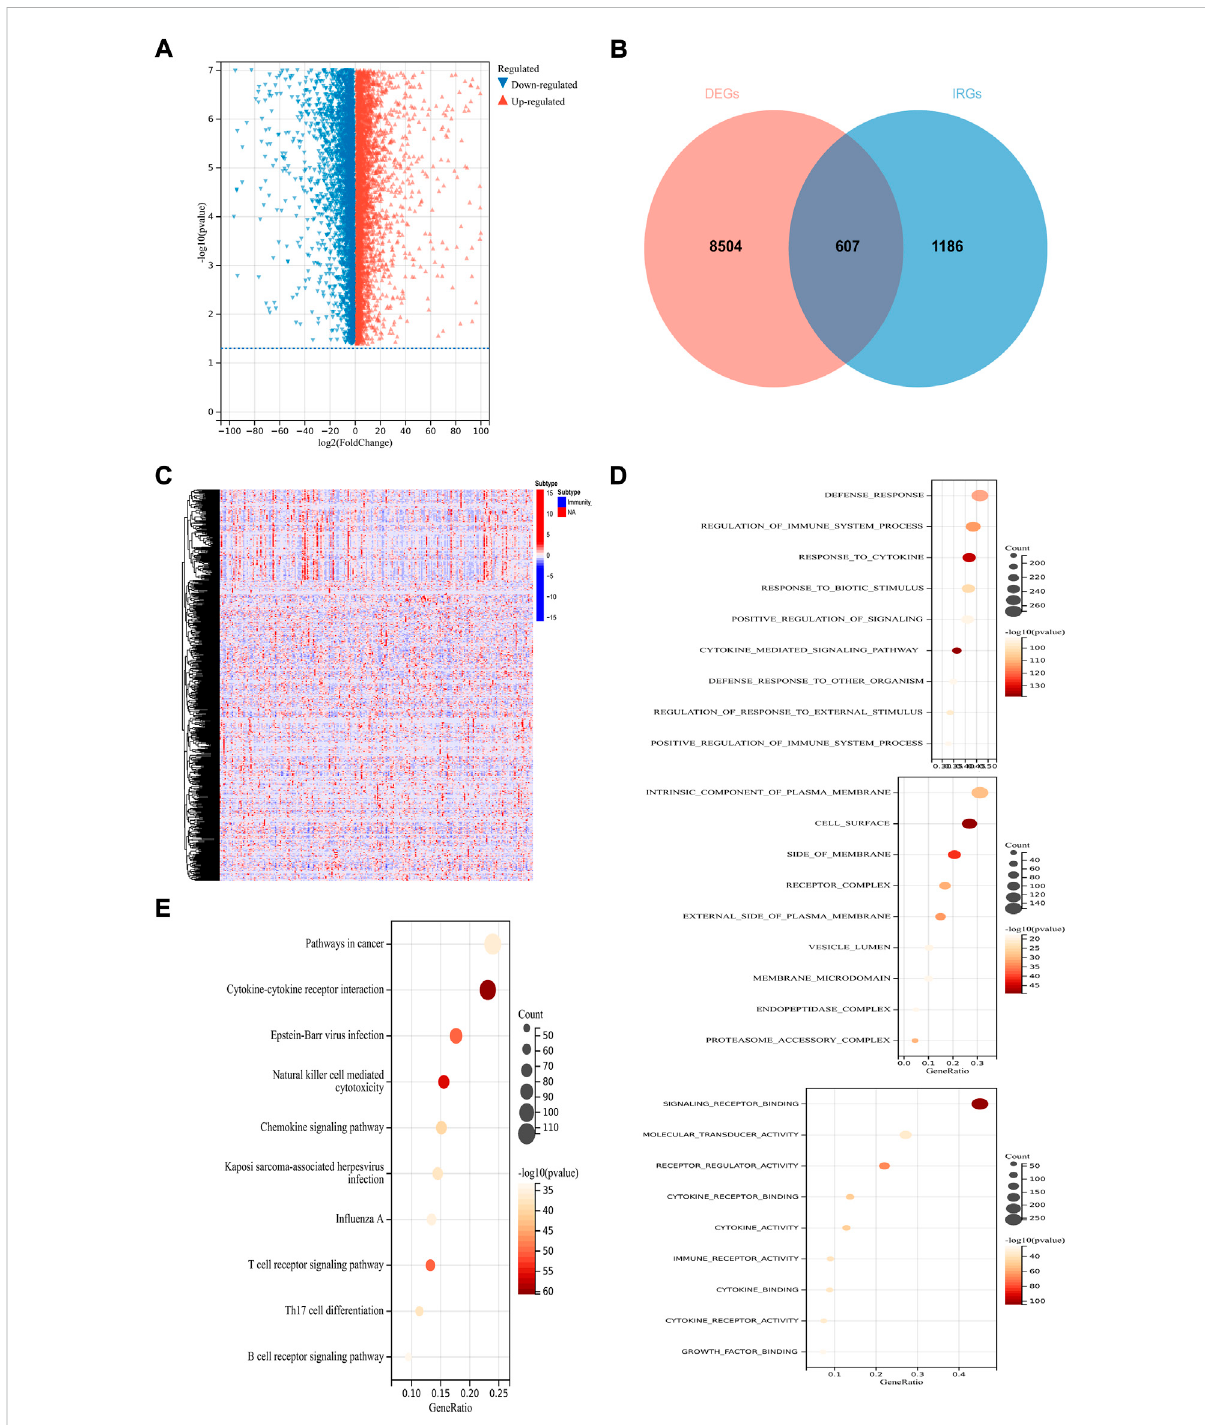
FIGURE 2 Identi fi cation of immune-related prognostic DEGs in CSCC. (A) The volcano plot of DEGs. (B) Venn diagram between DEGs and IRGs. (C) The heatmapofIR-DEGs. (D) GOenrichmentanalysisofIR-DEGs,fromtoptobottomarebiologicalprocessesanalysis,cellularcomponentsanalysisand molecular functions analysis. (E) KEGG enrichment analysis of